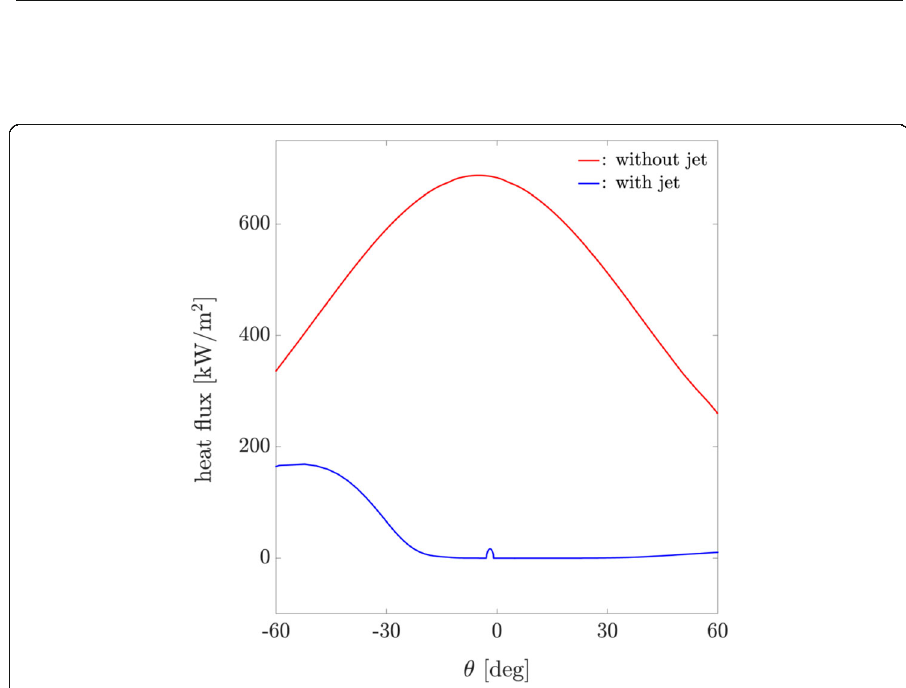
Fig. 12 The distribution of the heat flux along the cylinder corresponding to the temperature field shown in Fig. 11